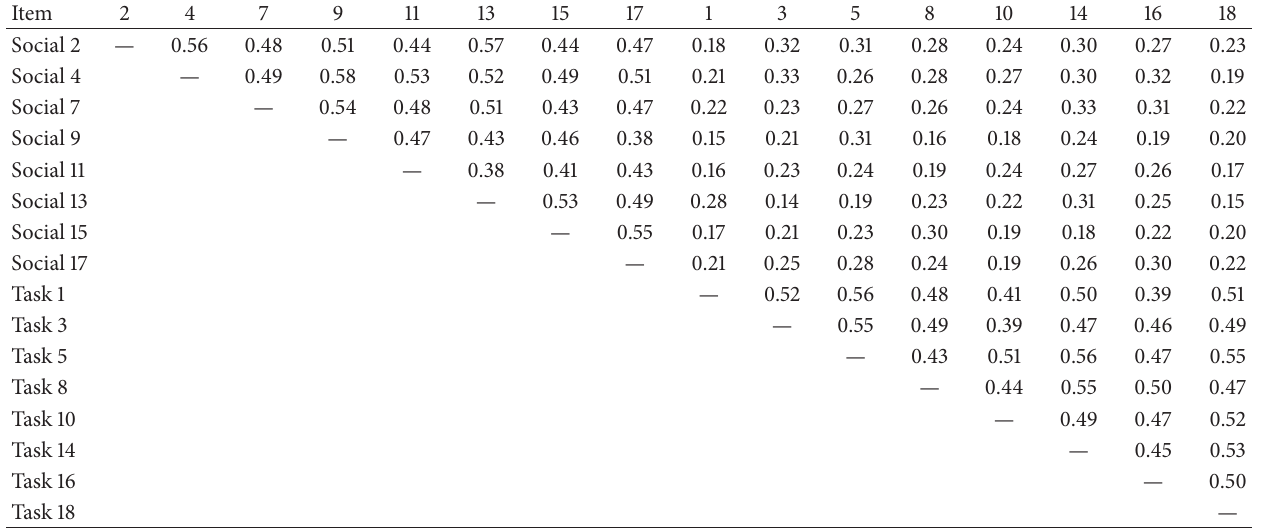
Table 2: Correlation matrix of the 16 items used in the confirmatory factor analyses.